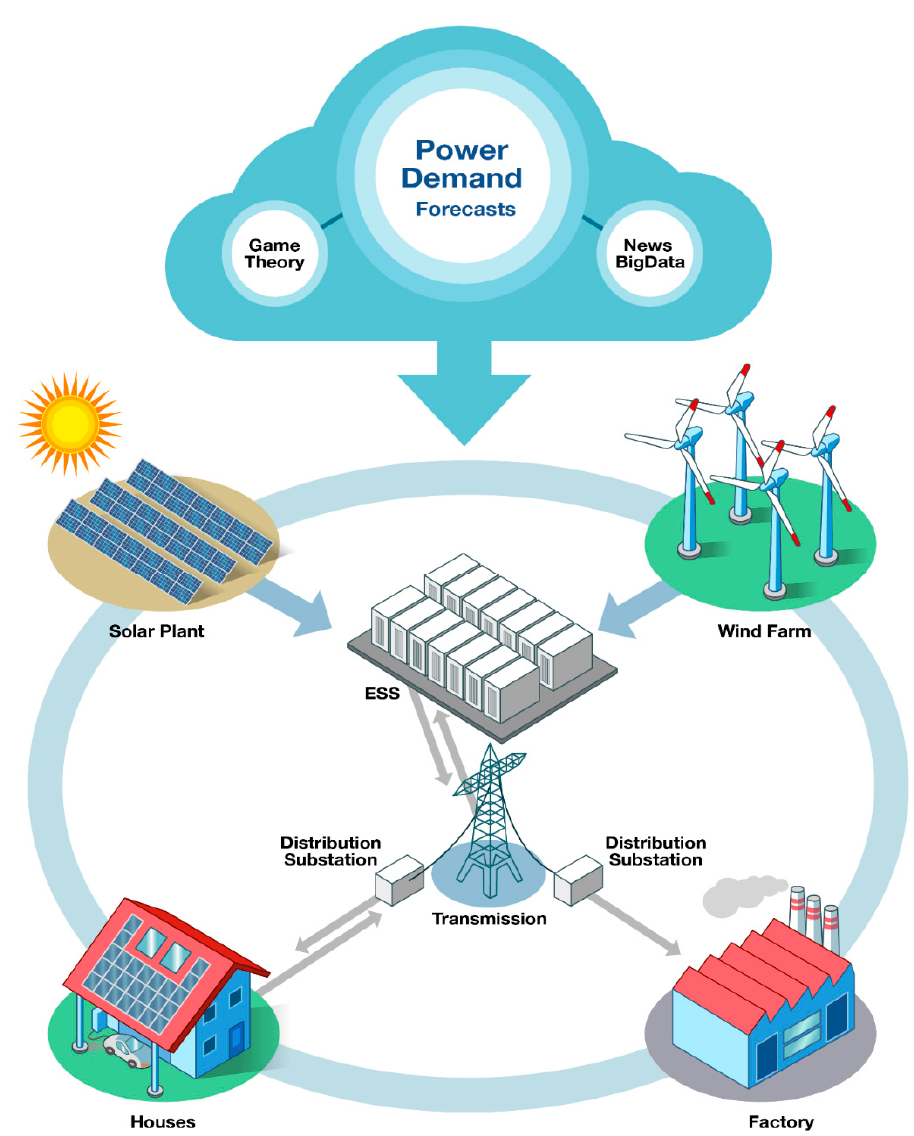
Figure 1. Graphical abstract of flexible and balanced electric power production-big data virtualization based on a photovoltaic power plant.